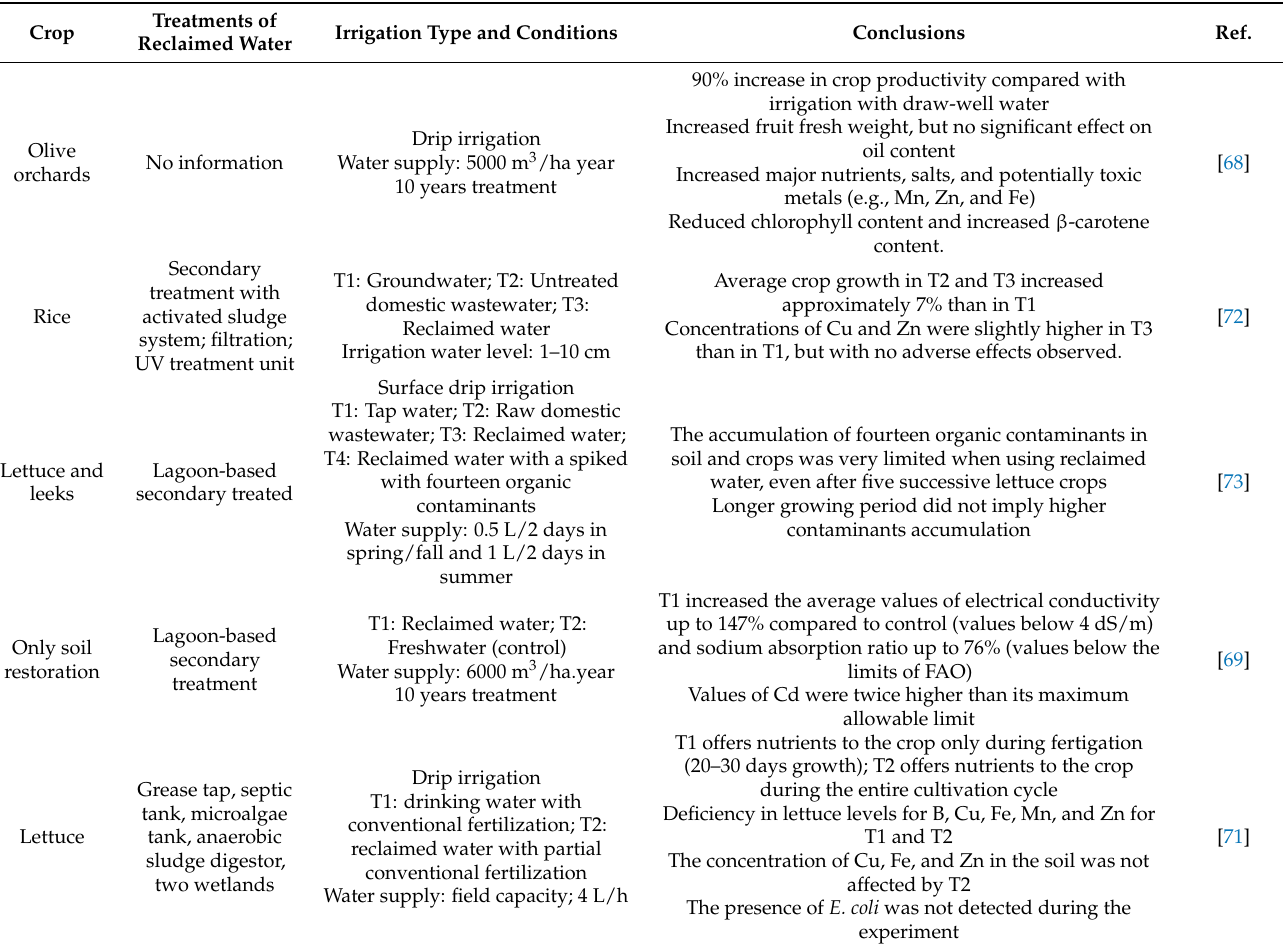
Table 8. Example of studies using reclaimed water for irrigation of agricultural